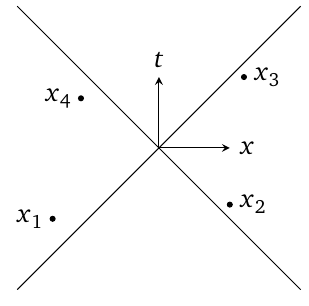
Figure 5.5: Regge